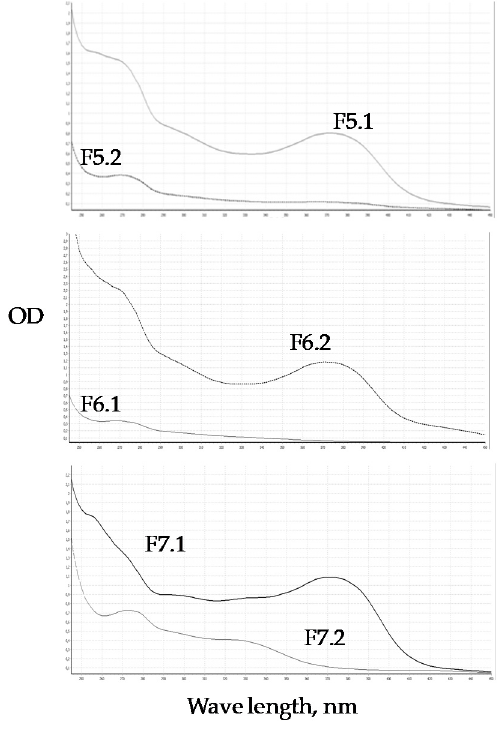
Figure 4. UV spectra referring to sub-fractions the T. clathrus ethyl acetate extract.